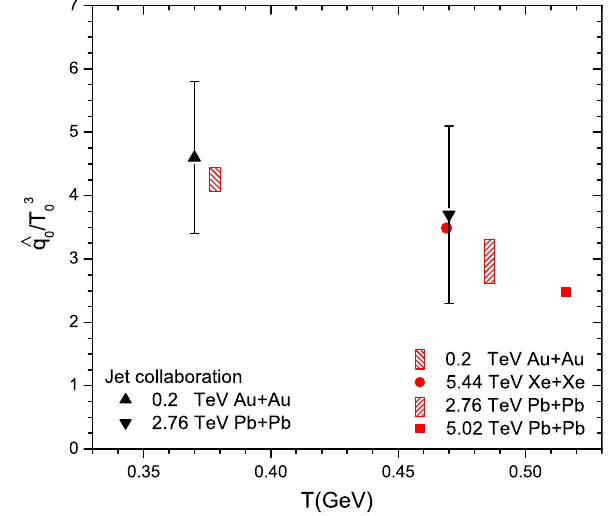
Fig. 9 The scaled jet quenching parameter ˆ q / T 3 extracted via single hadron and dihadron suppression data at RHIC and the LHC. The boxes are Jet Collaboration